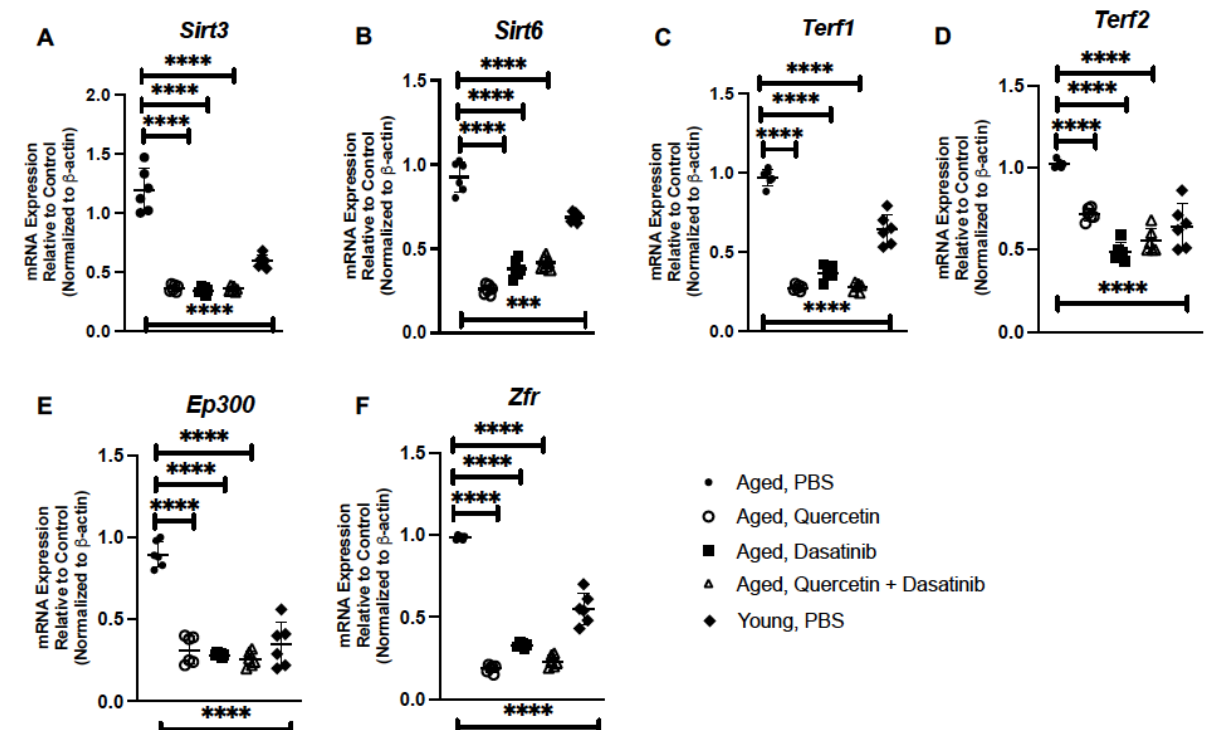
Figure 4. Treatment of Aged Mice with Senolytics Alters Senescence Modulatory Genes in Aged Lung. Lung tissue was collected from PBS-, quercetin-, dasatinib-, and quercetin + dasatinib-treated aged adult BALB/c mice (20 months of age). Expressions of ( A ) Sirt3, ( B ) Sirt6 , ( C ) Terf1, ( D ) Terf2 , ( E ) Ep300 , and ( F ) Zfr were assessed by real-time PCR. N = 6 mice per group, and the experiment was repeated 3 times. Young (3 months) PBS-treated lung expression analysis is included for comparison *** p < 0.001 and **** p < 0.0001.